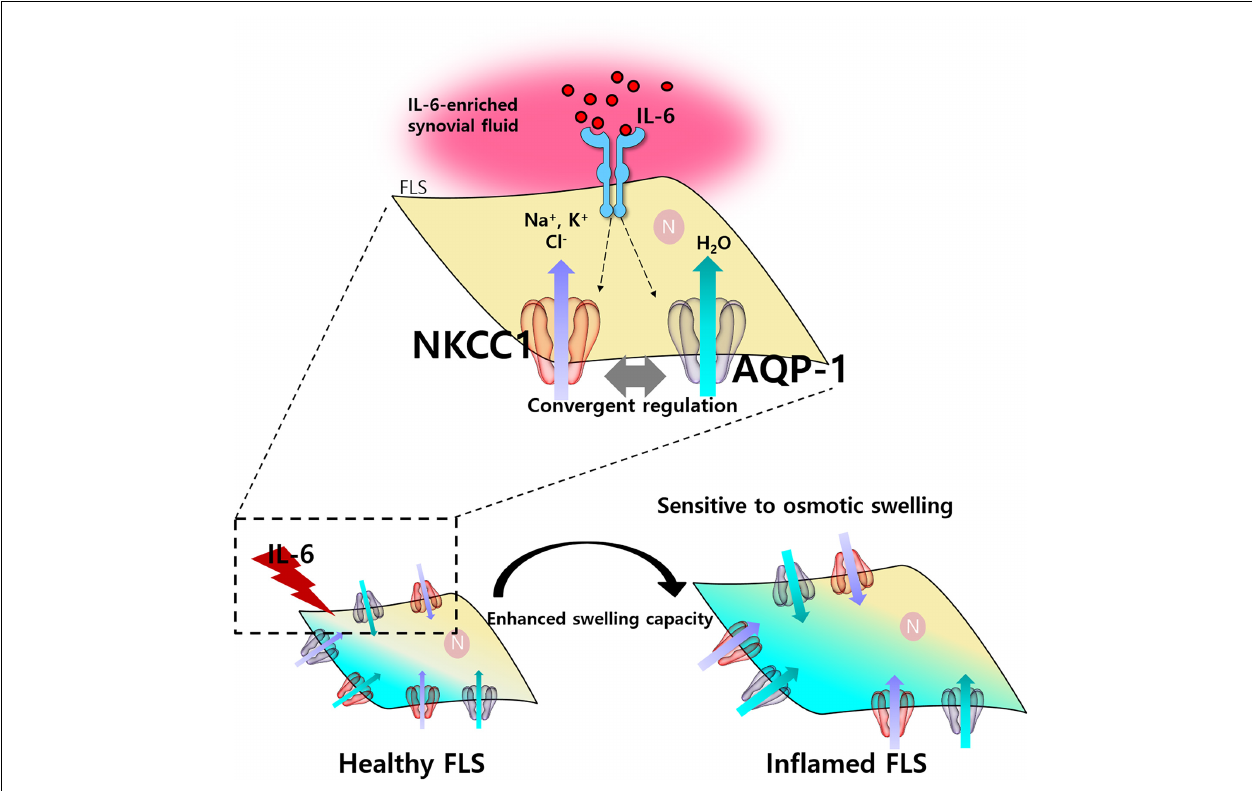
FIGURE 6 | Schematic illustration of osmotic change by interleukin (IL)-6 through sodium–potassium–chloride cotransporter1 (NKCC1) and aquaporin (AQP)-1 in fibroblast-like synoviocytes (FLS). IL-6-induced activation of NKCC1 and AQP-1 in FLS. Activation of NKCC1 and AQP-1 by IL-6/IL-6-enriched synovial fluid resulted in the influx of solute and water causing the sensitivity to hyperosmotic stimulation.